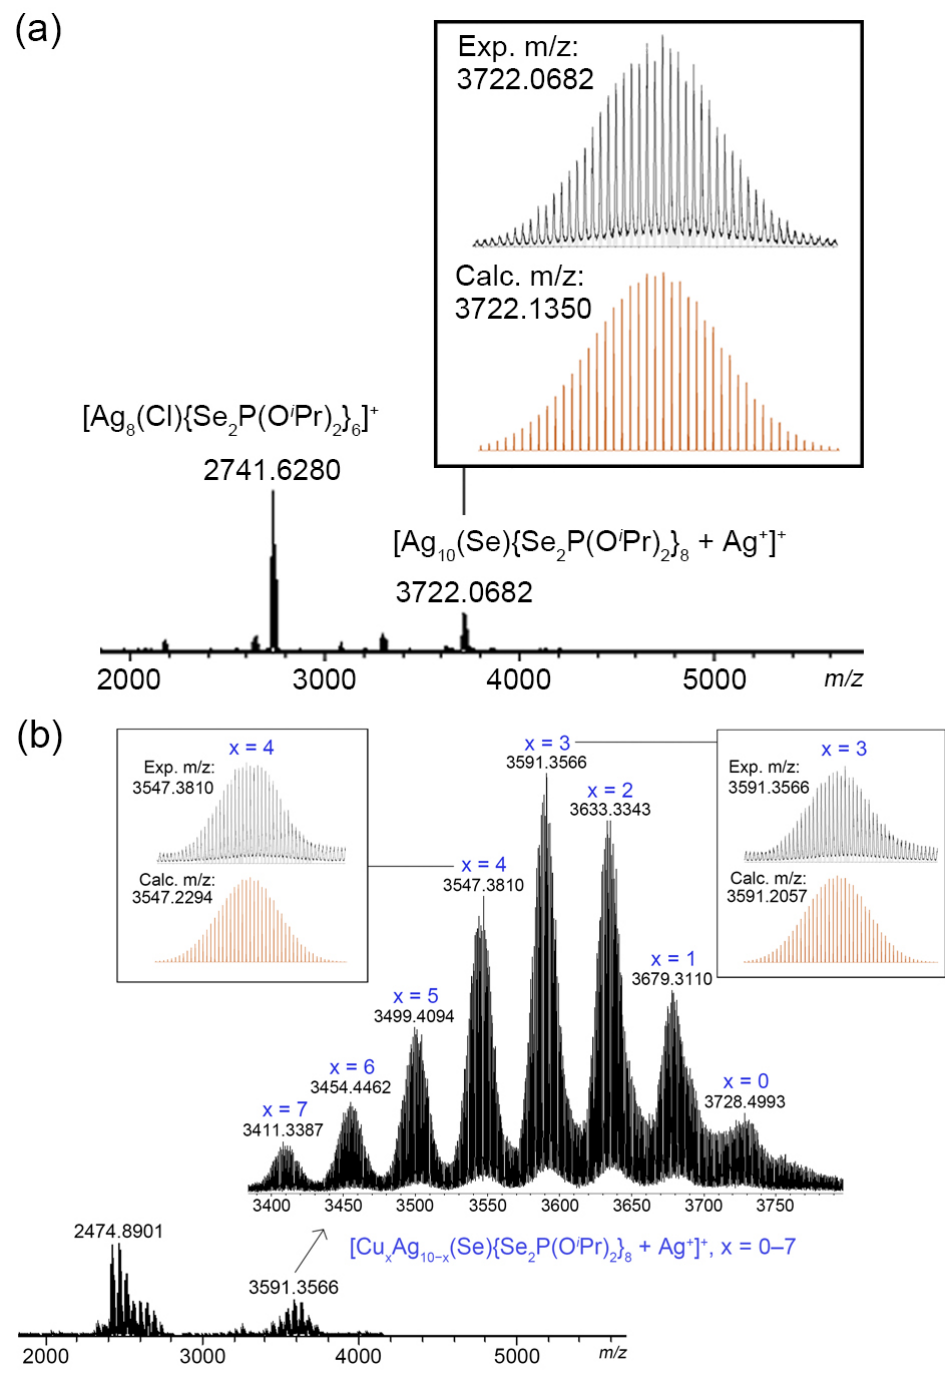
Figure 2. ( a ) The positive-ion ESI mass spectrum of 2 . The inset is the experimental (black) and simulated (orange) isotopic distribution pattern of [ 2 + Ag + ] + . ( b ) The positive-ion ESI mass spectrum of 3 . The inset is the experimental (black) and simulated (orange) isotopic distribution pattern of [Cu 3 Ag 7 (Se){Se 2 P(O i Pr) 2 } 8 + Ag + ] + and [Cu 4 Ag 6 (Se){Se 2 P(O i Pr) 2 } 8 + Ag + ] + .